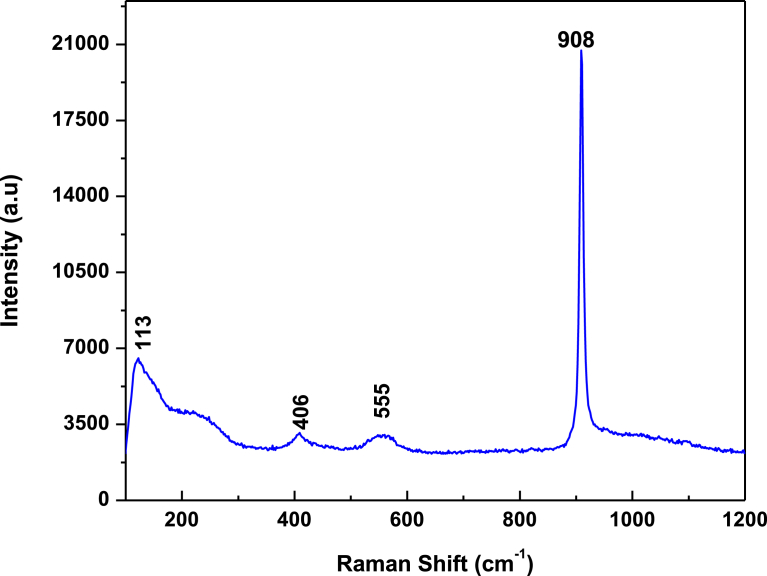
Raman spectra for pristine Ag3PO4 sample.